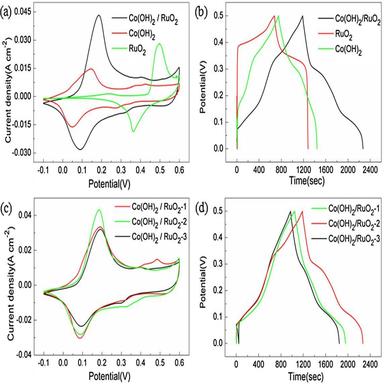
(a) CV graphs of the RuO2, Co(OH)2 and Co(OH)2/RuO2 at a scan rate of 5 mV s−1 ; (b) GCD curves of RuO2, Co(OH)2 and RuO2/Co(OH)2 at a constant current density of 1 A g−1 ; (c) CV graphs of the Co(OH)2/RuO2-1, Co(OH)2/RuO2-2 and Co(OH)2/RuO2-3 at a scan rate of 5 mV s−1 ; (d) GCD curves of the Co(OH)2/RuO2-1, Co(OH)2/RuO2-2 and Co(OH)2/RuO2-3 at a constant current density of 1 A g−1 .